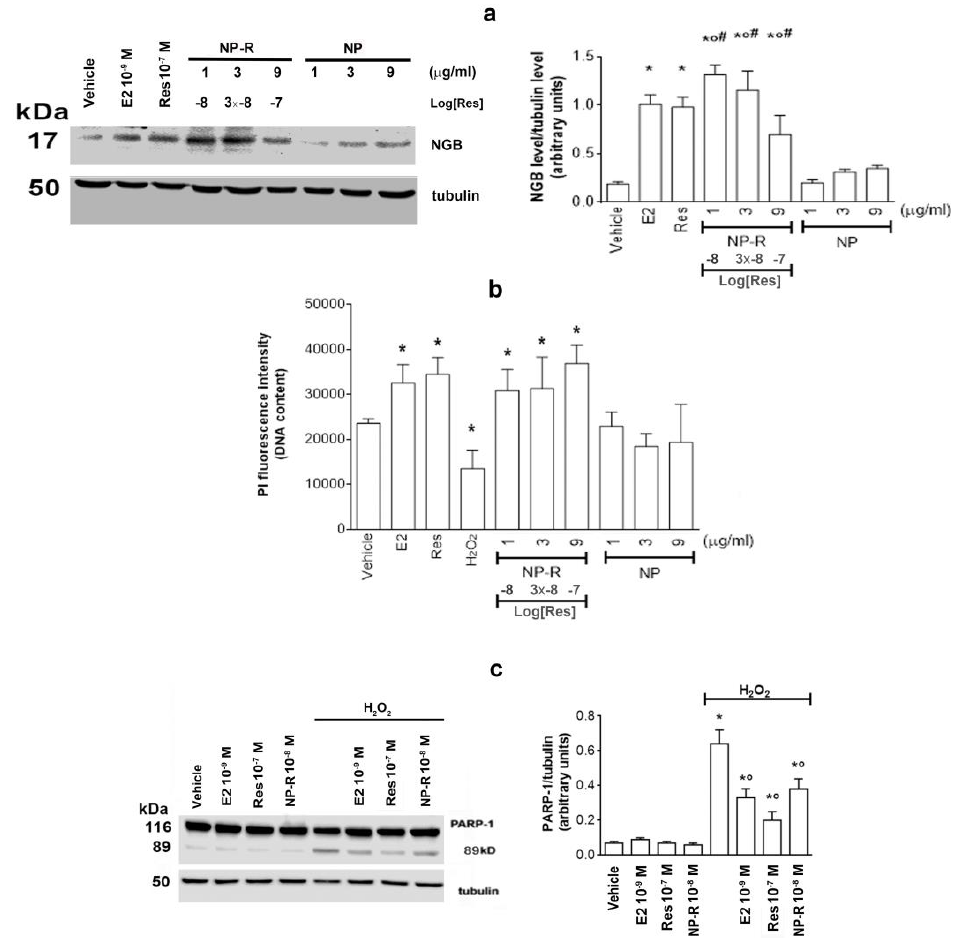
Figure 8. Effects of NP-R in SH-SY5Y Cells. ( a ) Analysis by Western blot of NGB levels in SH-SY5Y cells treated for 24 h with vehicle (DMSO 1: 1000, v : v ), E2 (10 − 9 M), Res (10 − 7 M), NP-R (1 to 9 µ g/mL of NP corresponding to a load of Res concentration, respectively, of 10 − 8 , 3 × 10 ~8 , and 10 − 7 M) and different concentrations of unconjugated NP (1 to 9 µ g/mL). The left panel shows a Western blot type, and the right panel shows the densitometric analysis of at least three different experiments. Tubulin protein was used to normalize blot loading. Data are reported as mean ± SD. p < 0.05 was calculated with Student’s t -test with respect to the vehicle (*) and Res (°) and unconjugated NP (#). ( b ) PI assay of NP-R in SH-SY5Y. Cells were treated as described in panel a . The data represent the mean ± SD of at least four different experiments. p < 0.05 was calculated with Student’s t -test with respect to the cells treated with vehicle (*). ( c ) Analysis by Western blot of PARP-1 levels in SH-SY5Y cells treated with vehicle (DMSO, 1:1000, v : v ), E2 (10 − 9 M), RSV (10 − 7 M), NP-R (1 to 9 µg/mL, Res loaded concentration of 10 − 8 M), and H 2 O 2 (5 × 10 − 5 M). The left panel shows a Western blot type, and the right panel shows the densitometric analysis of at least three different experiments. Tubulin protein was used to normalize blot loading. Data are reported as mean ± SD. p < 0.05 was calculated with Student’s t -test with respect to vehicle (*) and H 2 O 2 (°).